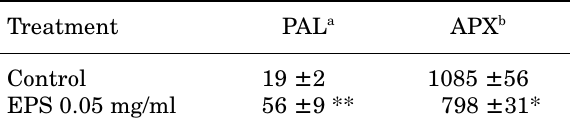
2. Changes in phenil alanine ammonia-lyase